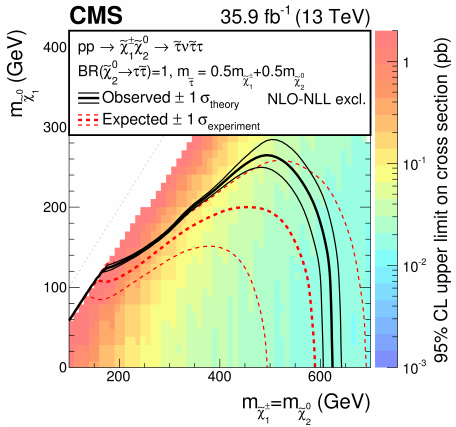
Figure 15: Interpretation of the results in the τ -dominated model with mass param- eter x = 0.5 [ 20 ] .